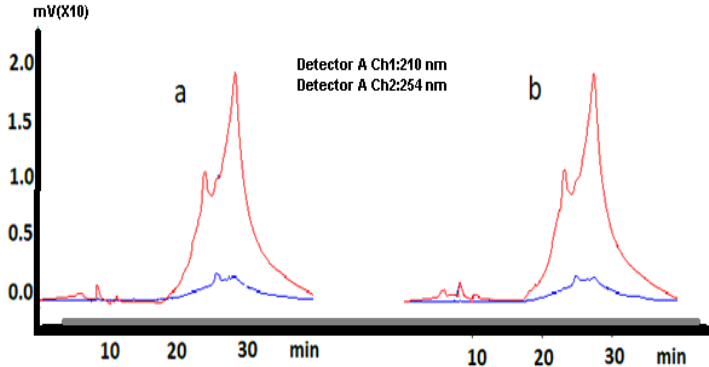
Figure 1. The HPLC analysis spectrum of goji berry extracts ta40 ( a ) and ta60 ( b ).